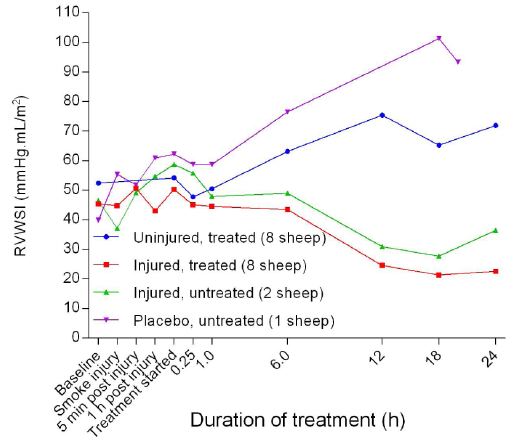
Figure 33. Right ventricular stroke work index (RVWSI) (Mean ± SD, error bars not shown) in smoke and non-smoke injured sheep that received extracorporeal life support as compared to that in untreated controls.